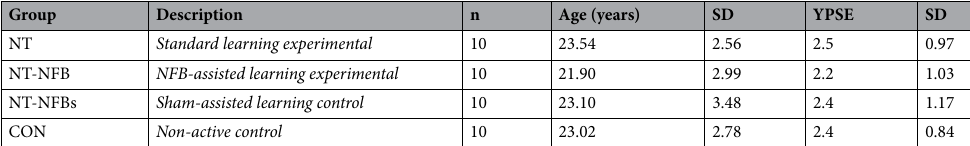
Table 1. Group breakdown demographics. Group composition and demographic information. YPSE: years of post-secondary education.